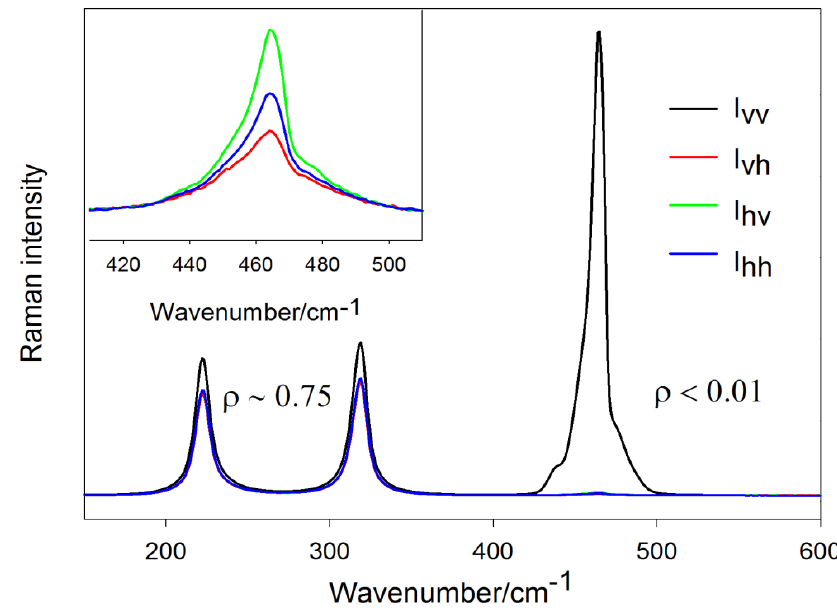
Figure 3. Polarized Raman spectra of CCl 4 . The excitation wavelength was 532 nm, laser power 100 mW and the accumulation time 1 min. No further corrections have been